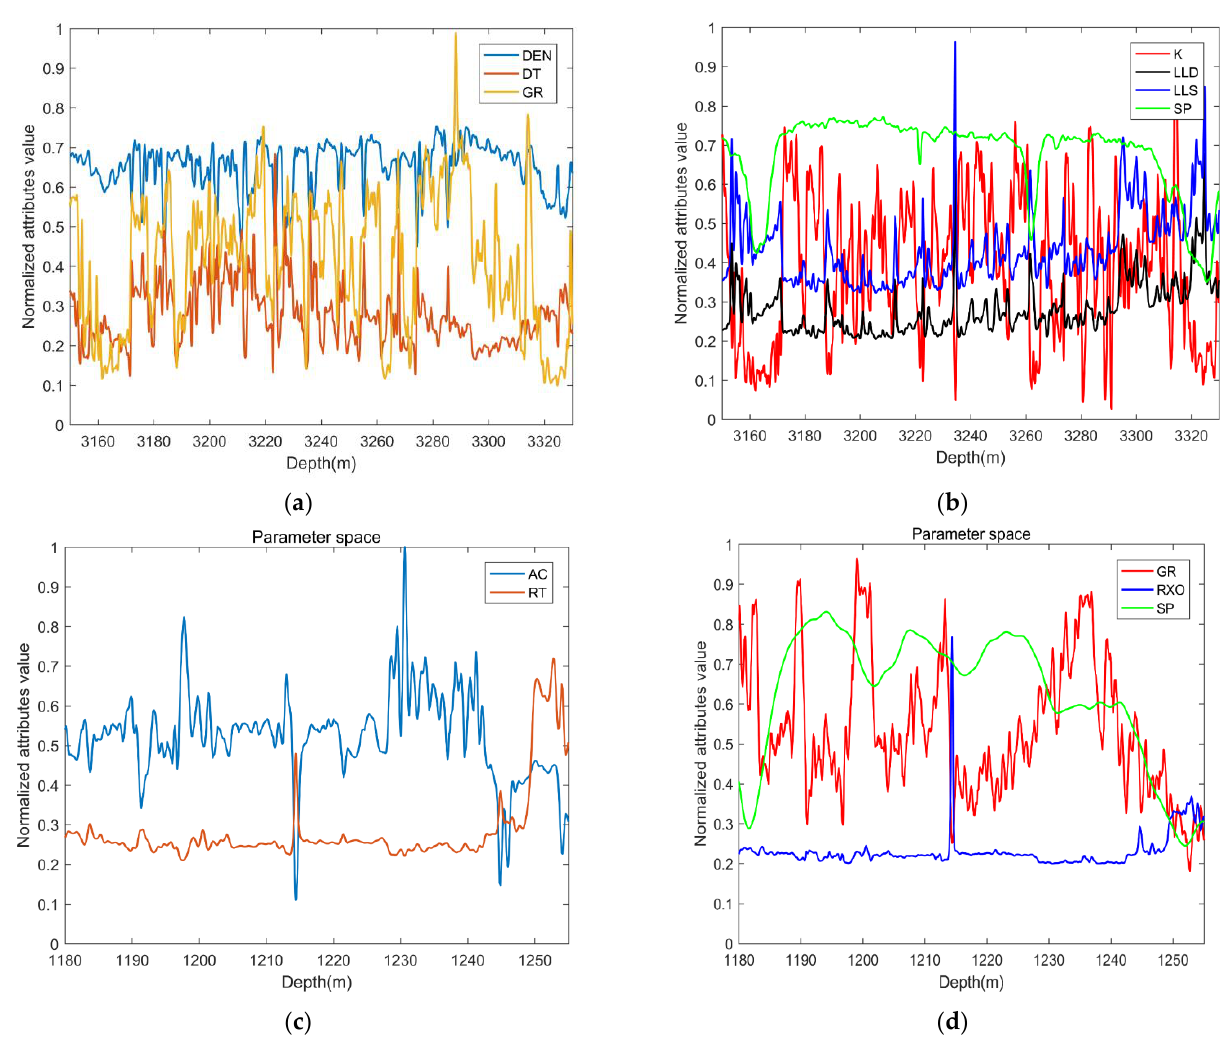
Figure 4. Normalized curves for each conditional property: ( a , b ) belong to well 1; ( c , d ) belong to well 2.